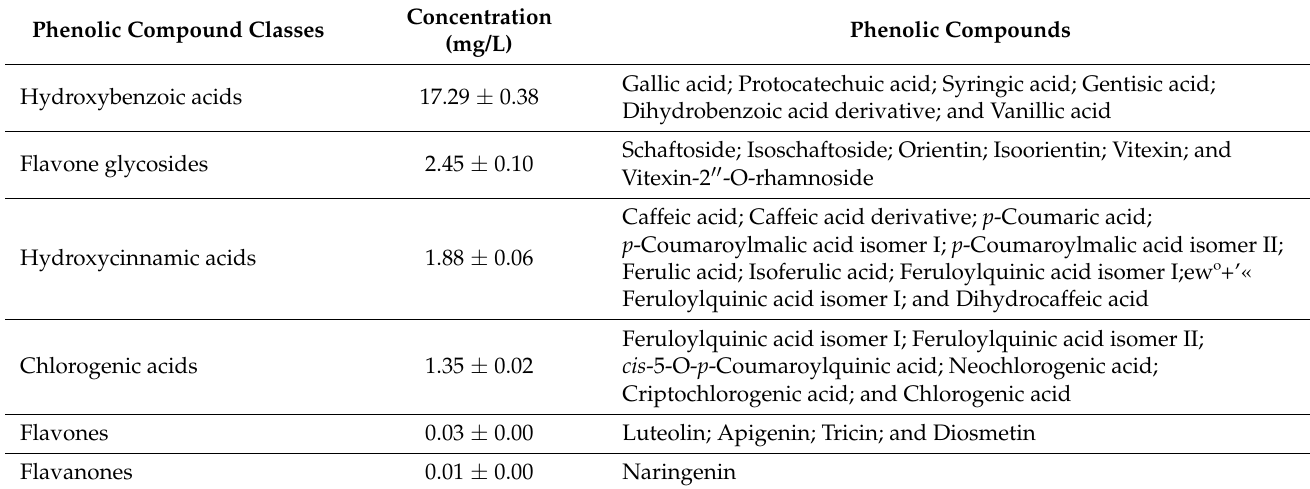
Table 5. Phenolic compound classes and content in the spent broth.